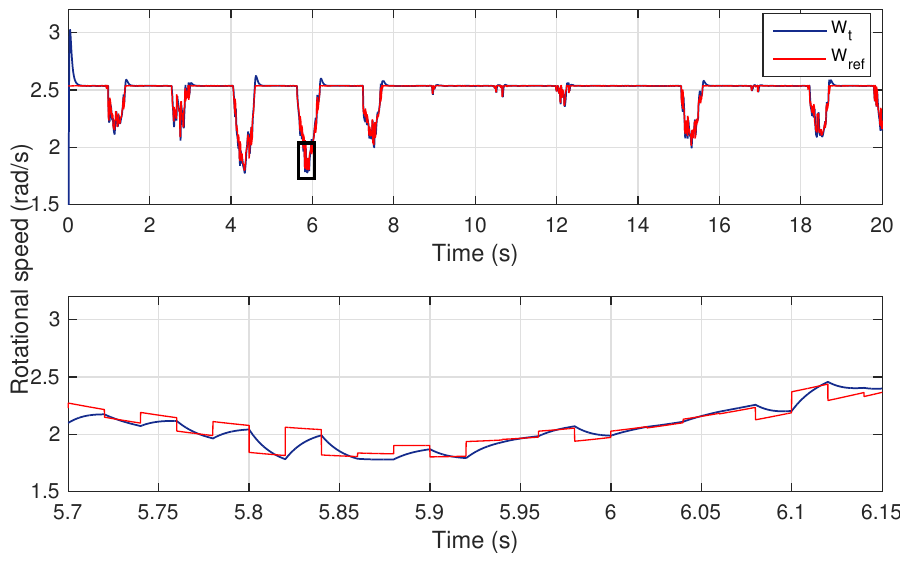
Figure 22. Case 2: Rotational speed and its reference curves.